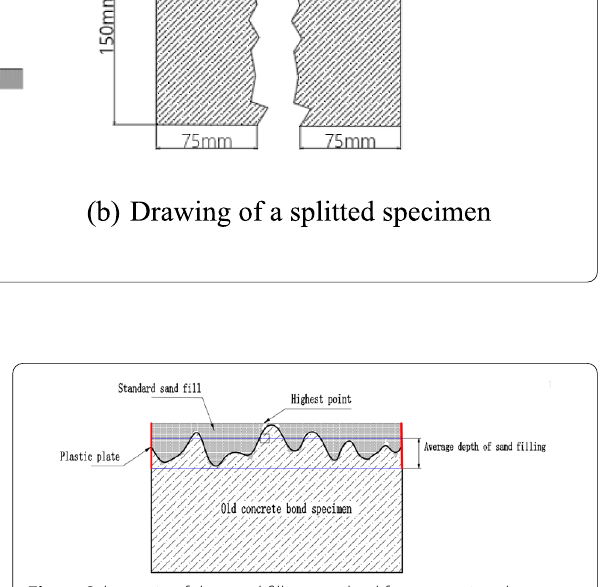
Fig. 4 Schematic of the sand filling method for measuring the roughness of the bonding